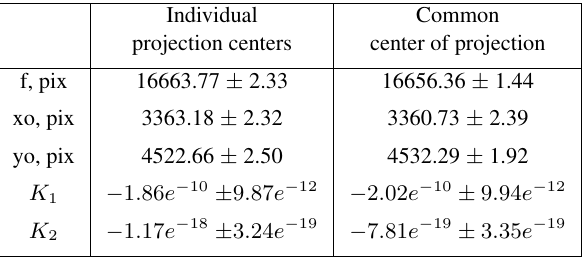
Table 2. The results of camera calibration – Hasselblad H4D-60.